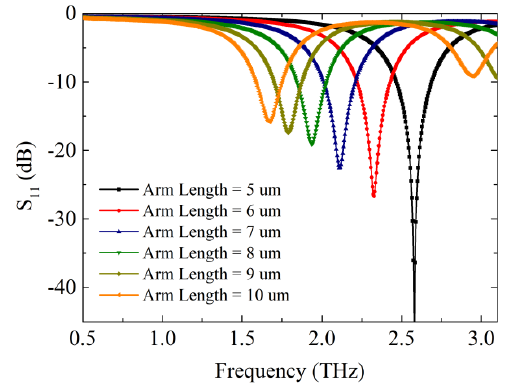
Figure 3. Simulated reflection coefficient with arm length ranging from 5 µm to 10 µm. The relaxation time is 0.5 ps and the temperature is 300 K.